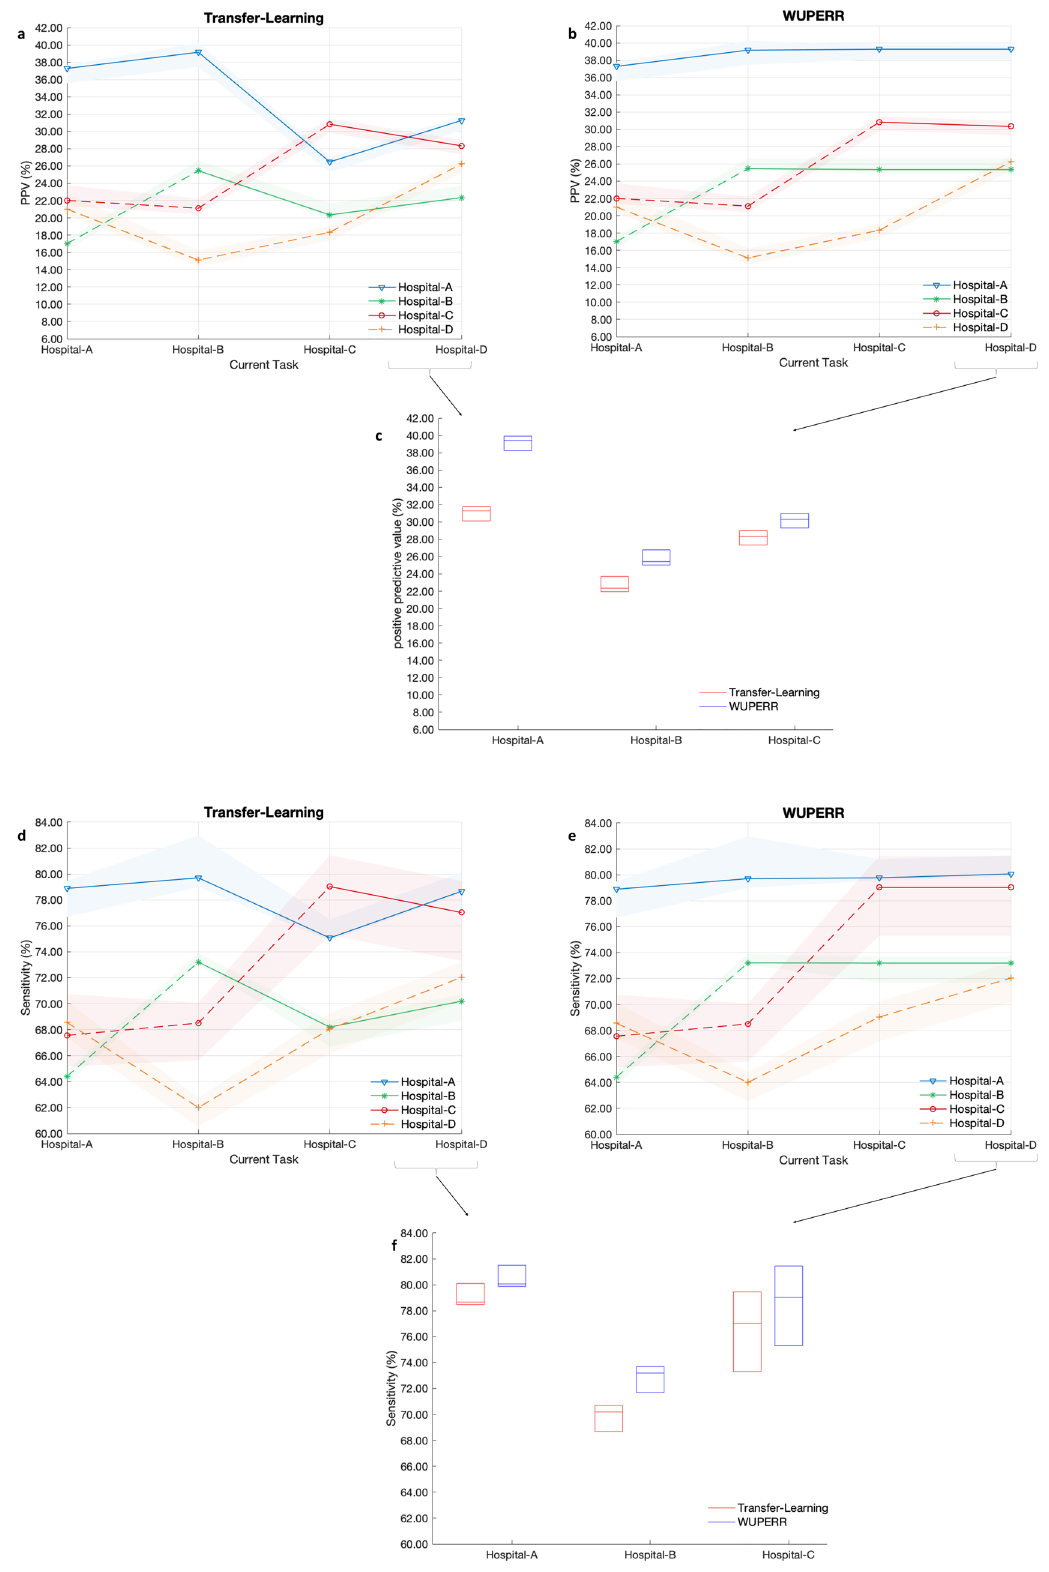
Figure 3. Evaluation of continual learning models for early predicting of onset of Sepsis, measured using positive predictive value (PPV) and sensitivity. (Atlanta) Illustrates the PPV of a model (median[IQR]) trained using transfer learning (measured at fixed threshold of 0.41 corresponding to 80% sensitivity at Hospital-A after Task 1, for all folds and across all tasks). The model performance is reported (using different markers; see legend) across all the cohorts after sequential training on data from a given hospital on the x-axis. (Atlanta) shows the PPV of the proposed WUPERR model, under the same experimental set-up as (Atlanta). (Atlanta) summarizes the model performance (median[IQR]) on Hospitals A-C after continual learning on all four hospitals with Transfer learning (red) and WUPERR (blue). ( d – f ) summarize the model sensitivity results under the same experimental